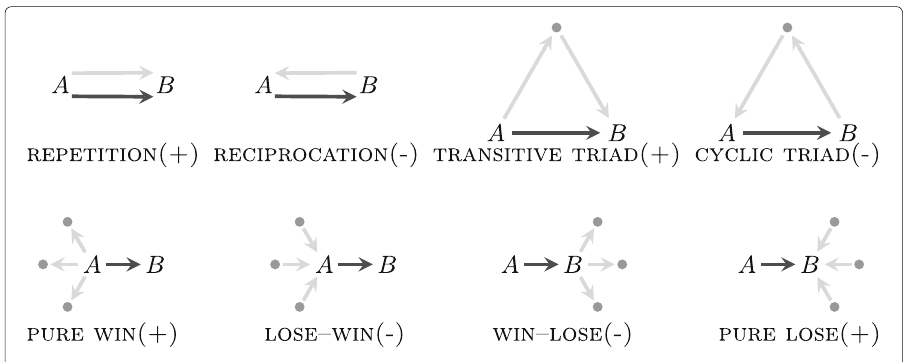
Fig. 1 Local configurations of dominance-establishing precursor events ( lightgrayedges ) predicting future undo edit event from A to B ( darkgrayedges ). Aplussign (+) [ minussign (-)] indicates the hypothetical increase [decrease] in the probability of observing the next event on ( A , B ) given the precursor configuration. These hypotheses are derived from the assumption that undo events or third-party edit events point from higher to lower in the hierarchy (see the text for details). Note that the edges are not binary (present/absent) network ties, but have weights between zero and